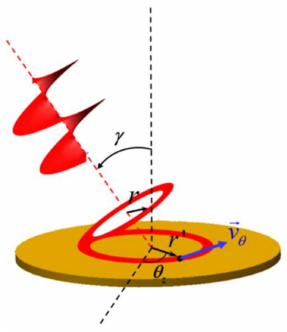
Figure 16. Elliptical profile of vortex beam at oblique incidence. Adapted with permission from ref.